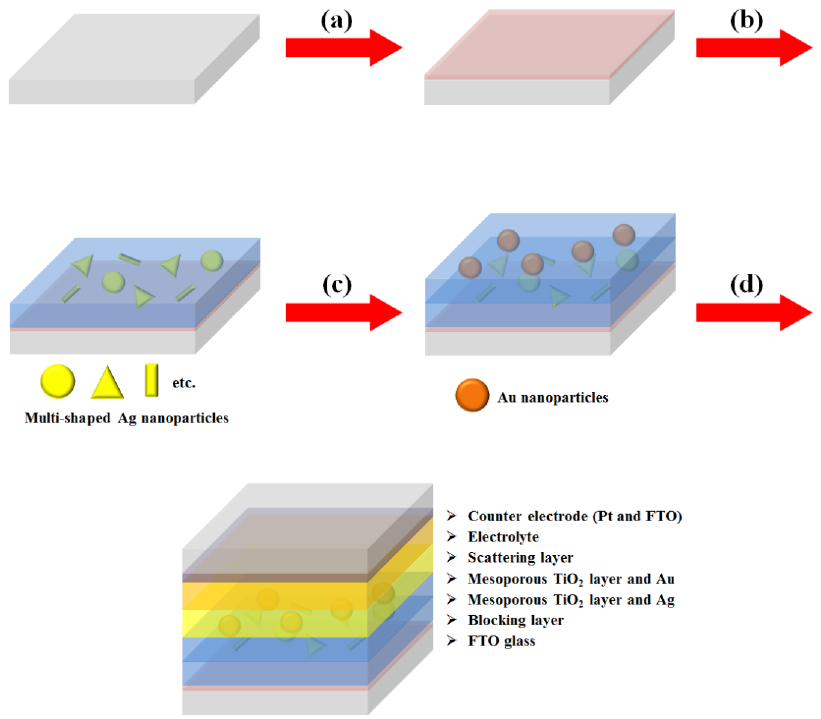
Figure 5. Fabrication process of dye-sensitized solar cells based on a composite film structure with multi-shaped Ag and Au nanoparticles (NPs): ( a ) coating of the TiO 2 blocking layer, ( b ) coating of multi-shaped Ag NPs and mesoporous TiO 2 NPs, ( c ) recoating of the Au NPs and mesoporous TiO 2 NPs, and ( d ) fabrication of the DSSC.